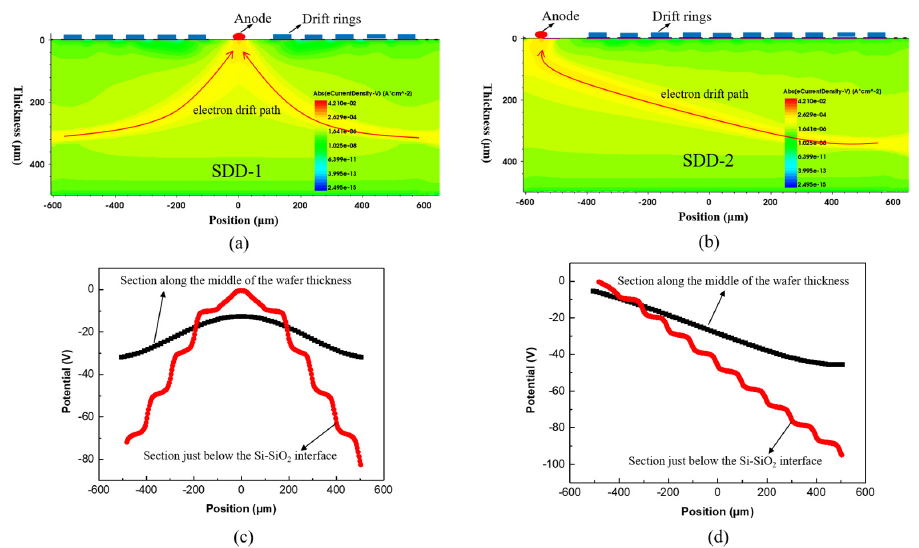
Figure 3. ( a , b ) The simulated profile of the electron current density of SDD-1 and SDD-2, respectively. The simulated structure with only the active region and the entrance window is not shown here. ( c , d ) The simulation of the potential distribution of SDD-1 and SDD-2 with only active region, respectively. The red line represents the potential profile below the Si-SiO 2 interface and the black line represents the potential profile along the middle of the wafer thickness.